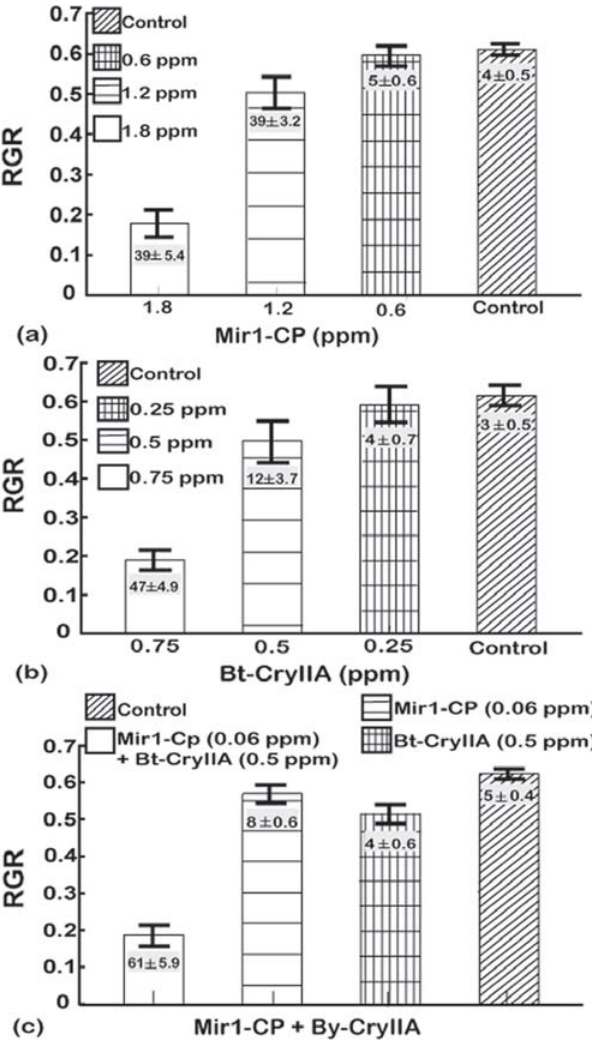
Figure 1. Dose response analysis for corn earworm larvae fed (a) Mir1-CP, (b) Bt-CryIIA, and (c) sub-lethal doses of Bt-CryIIA and Mir1-CP. The y-axis is the relative growth rate (RGR measured as D mg/ (mg avg d) and vertical bars indicate one standard deviation. The least significant difference (LSD) at the 0.05 confidence level for the RGR values were as follows: Mir1-CP=0.25, Bt-CryIIA=0.3, sub-lethal doses of Bt- CryIIA and Mir1-CP=0.42. Numbers (mean 6 SD) in the histogram bars are the average percentage mortality for each treatment. The least significant difference (LSD) at the 0.05 confidence level for mortality were as follows: